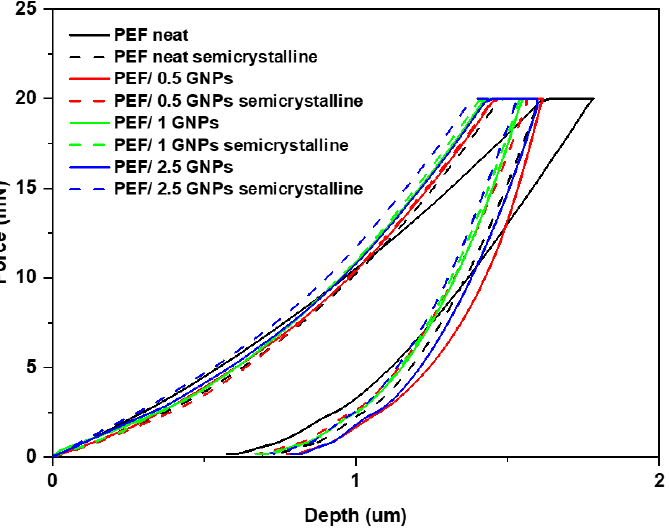
Figure 10. Comparison of the representative load – depth nanoindentation curves of the amorphous and semicrystalline neat PEF and PEF/GNP nanocomposites.